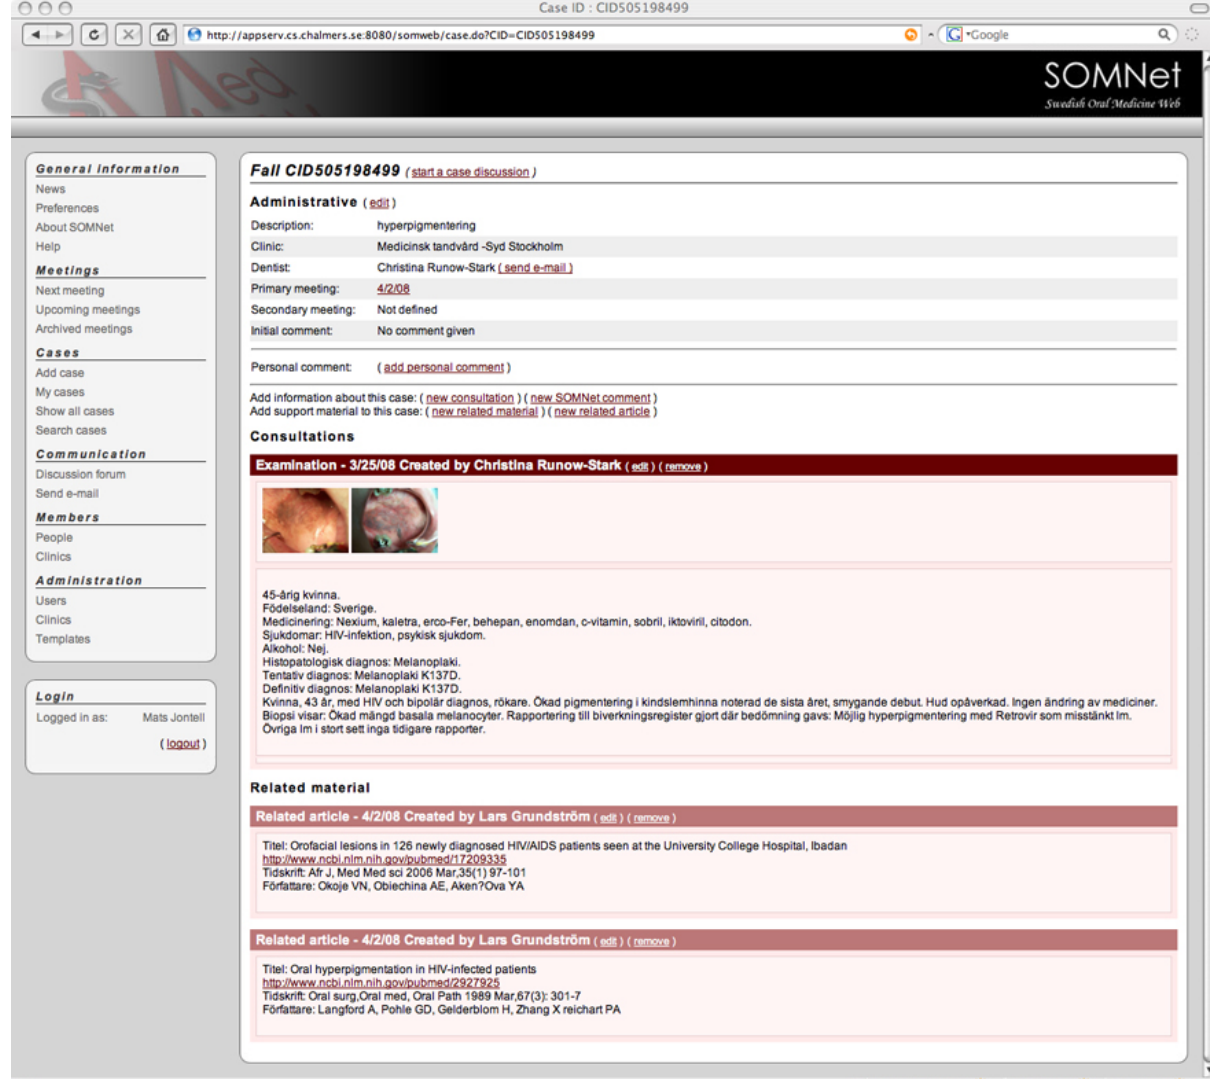
Figure 6. Case presentation page listing administrative data, consultation occasions with summarized case data and associated images, and related